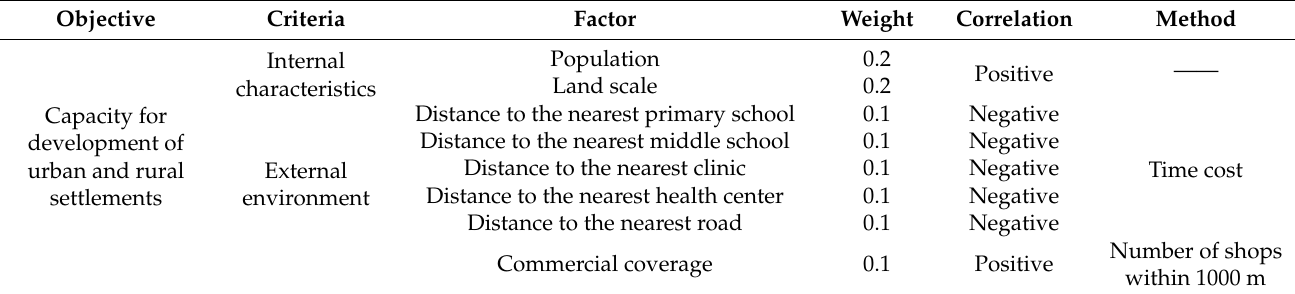
Table 1. Evaluation index system of the capacity for development of urban and rural settlements.